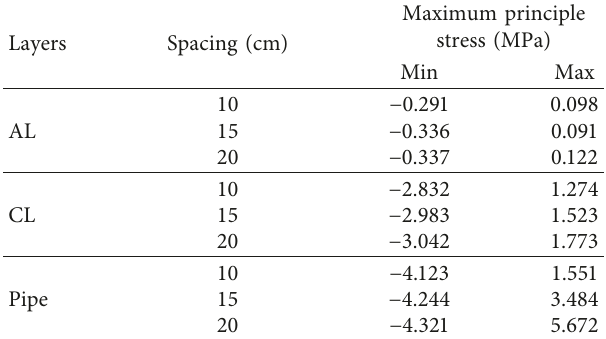
Table 7: Maximum principle stress extreme values of HSMP with fluid circulation (pipe embedded depth of 7cm). Layers Spacing